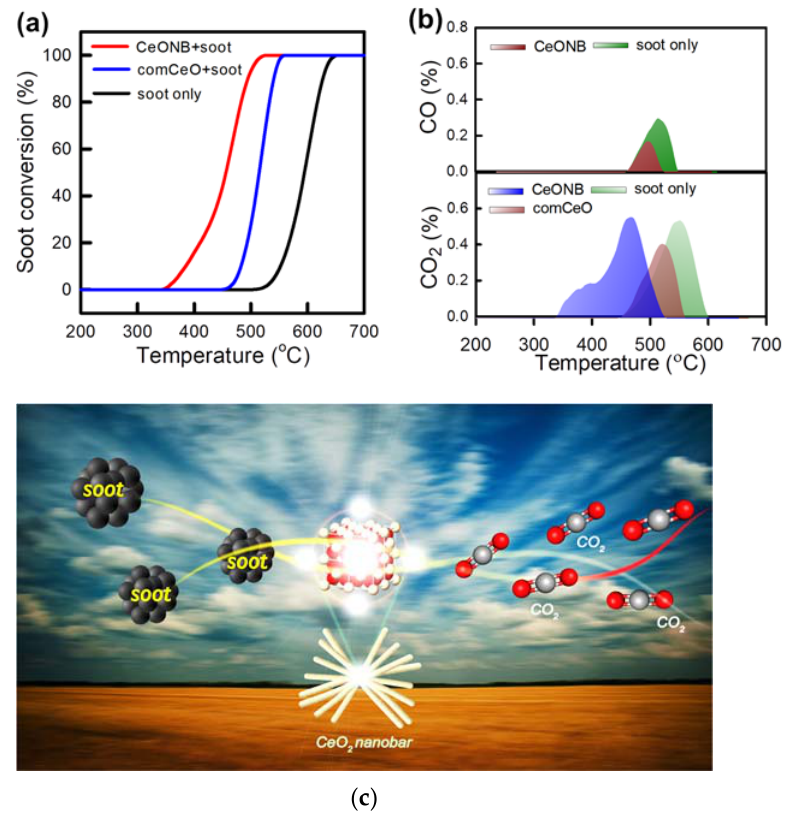
Figure 7. Soot oxidation by CeONB and comCeO: ( a ) soot conversion (%) under the loose contact mode and ( b ) concentrations of CO, and CO 2 during soot oxidation; ( c ) illustration of selective soot oxidation by CeONB.